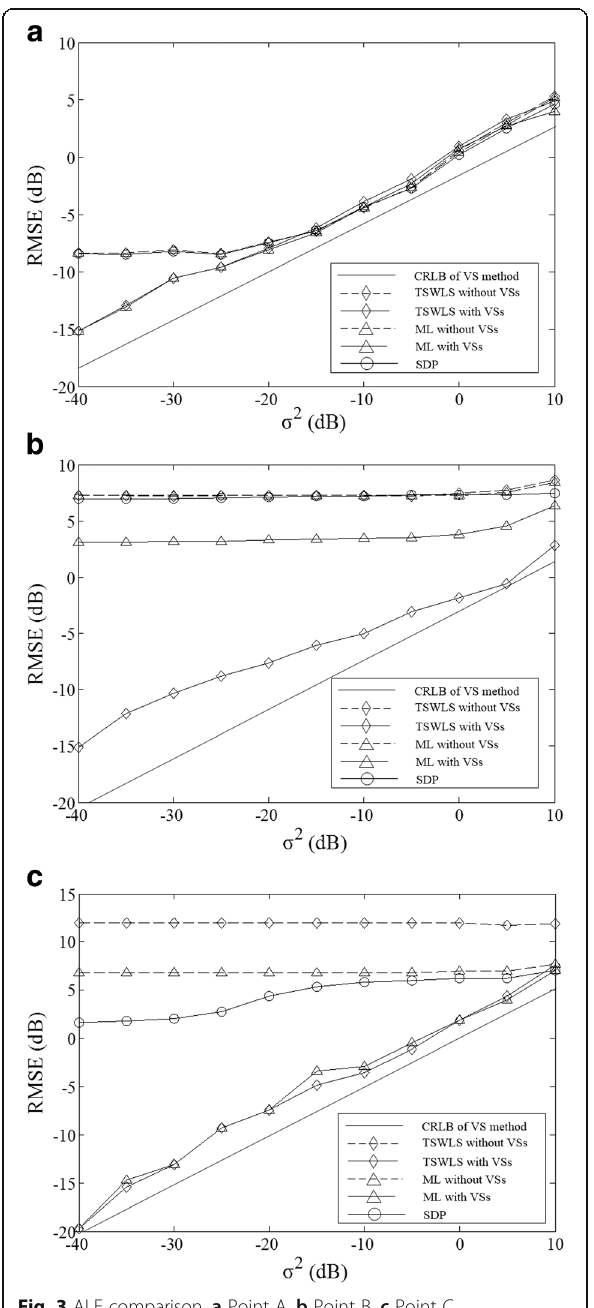
Fig. 3 ALE comparison. a Point A. b Point B. c Point C